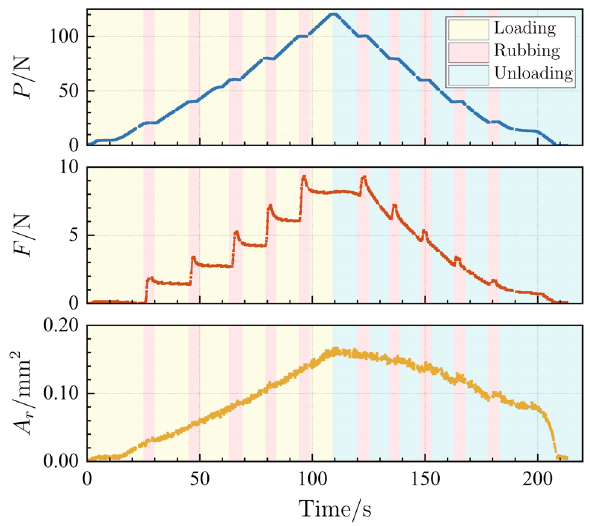
Figure 3. Evolutions of real contact area A r , normal load P , and the friction force F versus time for sample